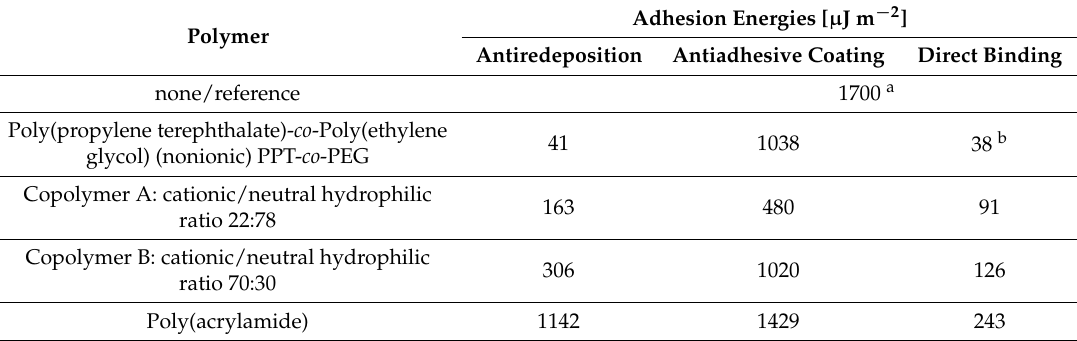
Table 1. Soil release polymer samples and adhesion energy from the three different assays. a Direct binding experiment between cellobiose SCP and hydrophobic surface. b Polymer was physisorbed on the glass/glymo